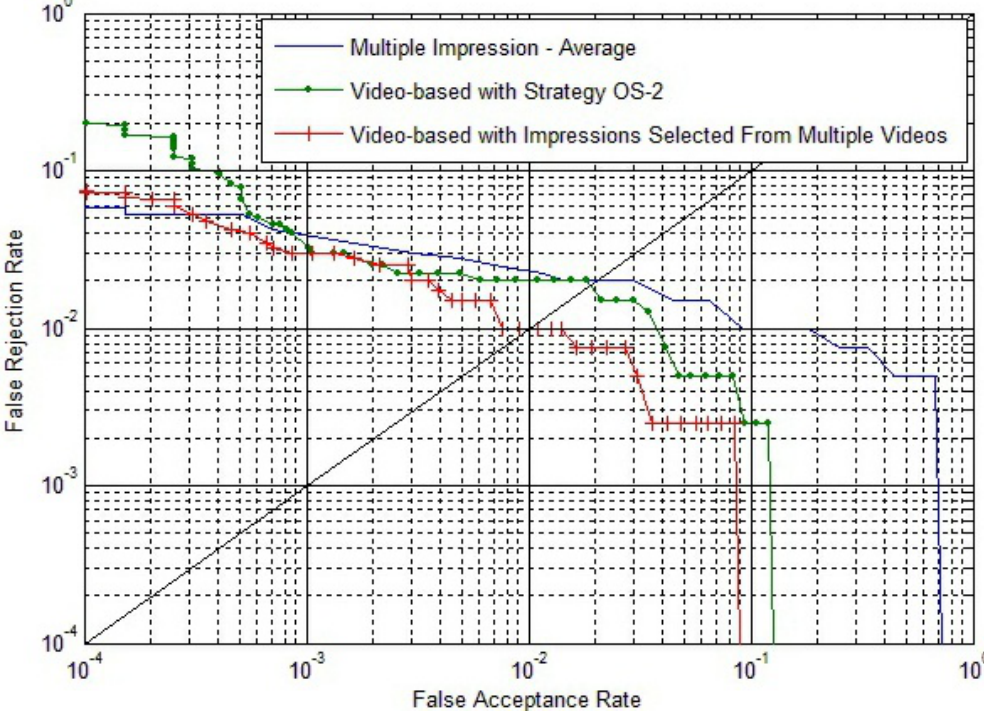
Figure 17. ROC of the multiple impressions fusion method, the proposed video-based method and the video-based method with impressions selected from multiple